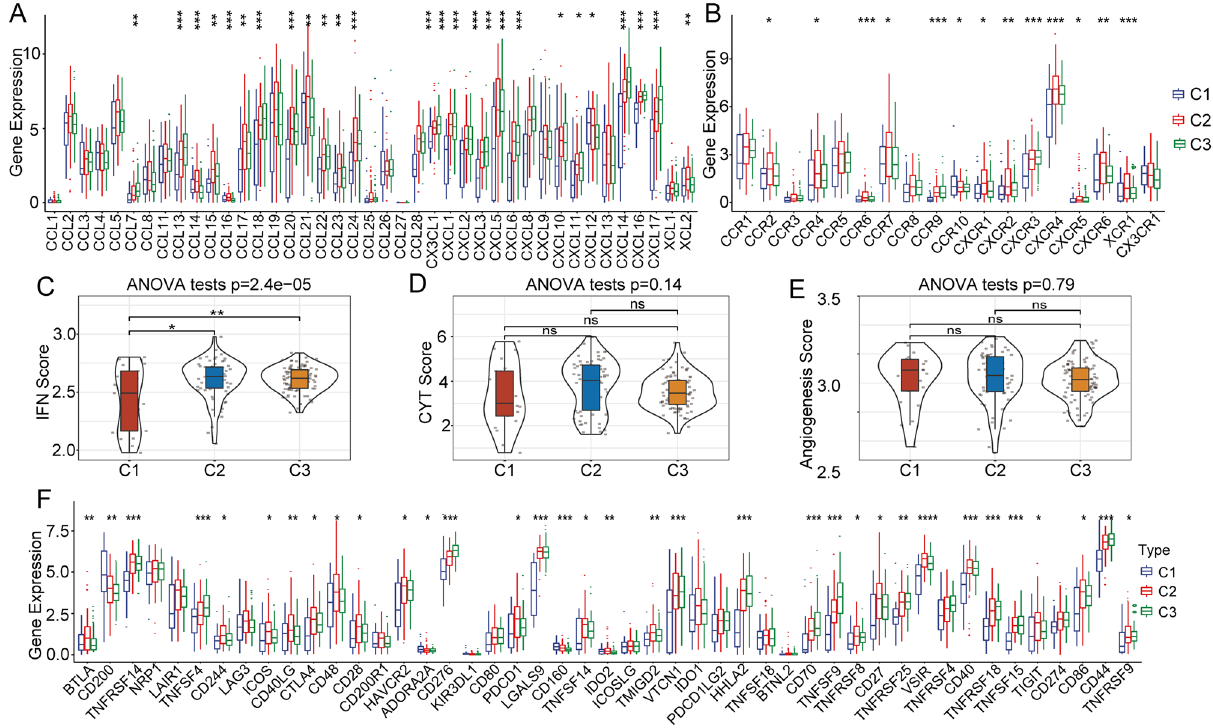
Figure 4. Expression of chemokines and immune checkpoint genes in different epi-PCG clusters. ( A ) Differences in the expression of chemokines among different clusters in the TCGA cohort. ( B ) Differences in the expression of chemokine receptors among different clusters in the TCGA-PACA cohort. ( C ) Differences in the distribution of IFNγ scores among different clusters in the TCGA cohort. ( D ) Differences in the cytolytic activity of T cells in different clusters. ( E ) Differences in angiogenesis scores among different clusters. ( F ) Differences in the expression and distribution of immune checkpoint genes in the TCGA-PACA cohort. A P value < 0.05 indicates statistical significance (* P < 0.05; ** P < 0.01; *** P <